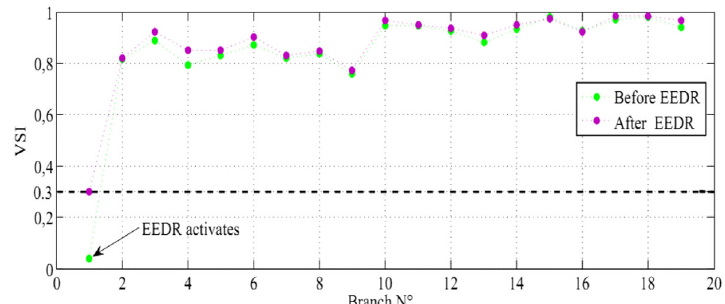
Fig. 12 VSI before and after EEDR in the case of loss of line (1 – 2) in the IEEE 14-bus system